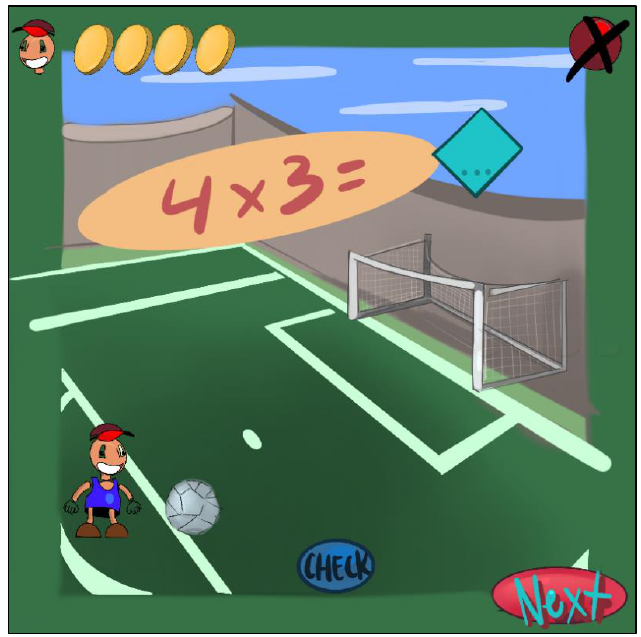
Figure 4. Gap-filling question in fourth scene. Information 2020 , 11 , 176